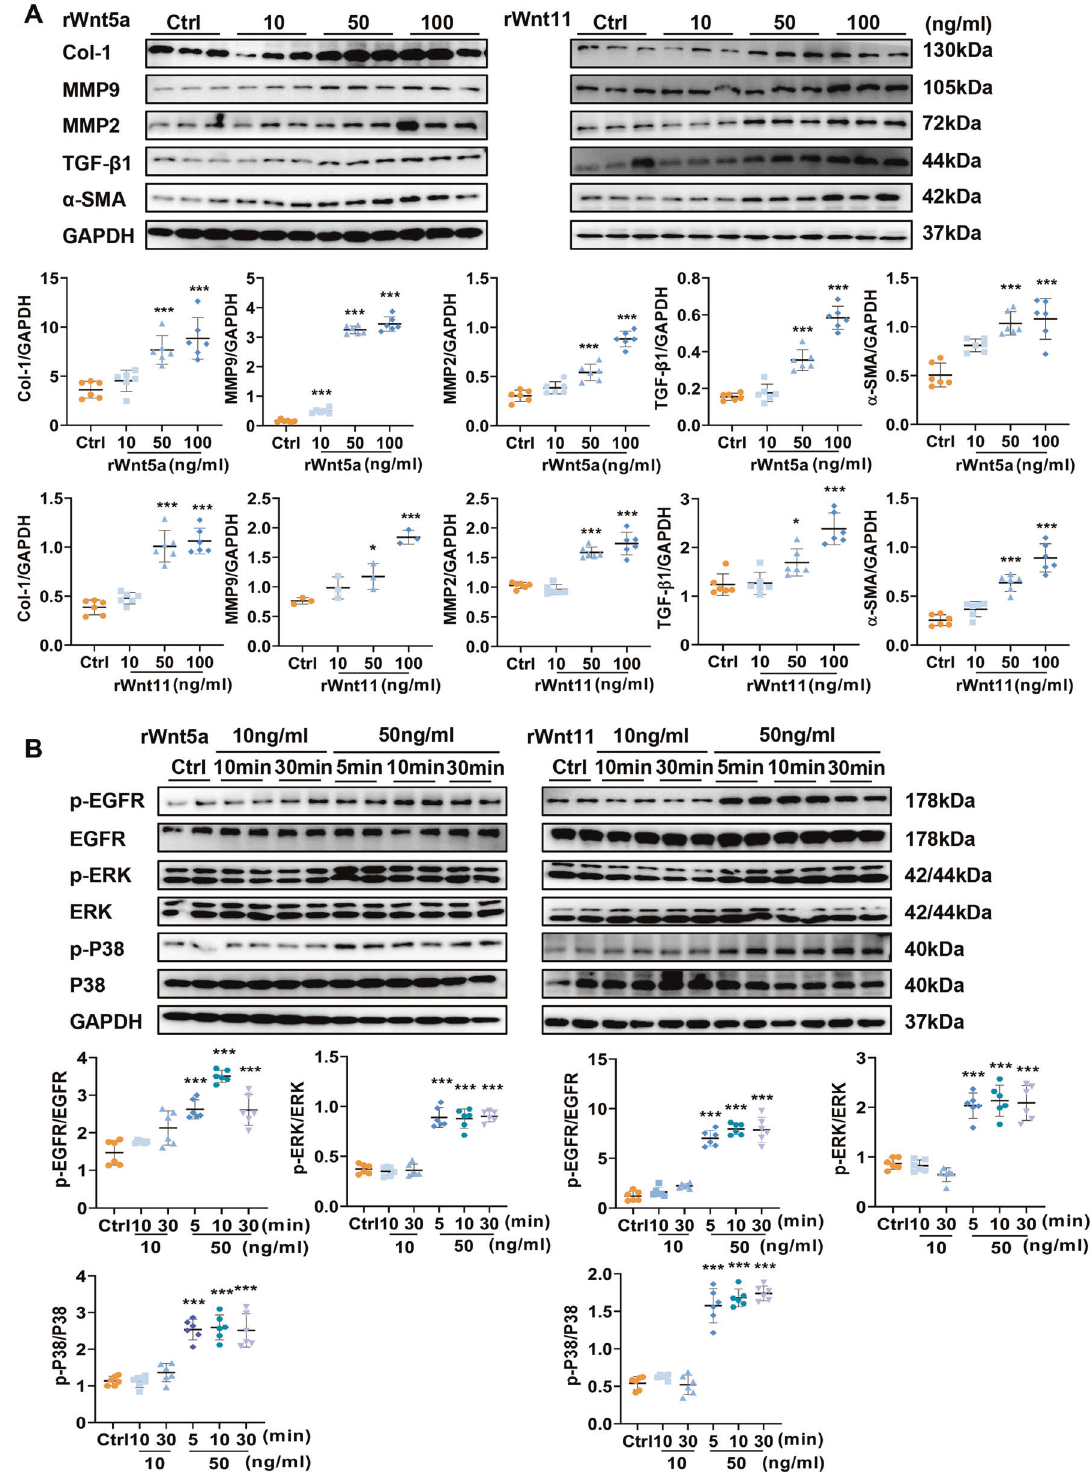
Fig. 6 Exogenous Wnt5a and Wnt11 activates fi brosis-related signaling in neonatal rat cardiac fi broblasts. A The expression of Col-1, MMP9, MMP2, and TGF- β 1 were detected by western blot analysis in cardiac fi broblasts stimulated with exogenous recombinant rat Wnt5a (rWnt5a) or Wnt11 (rWnt11) at different concentrations (0, 10, 50, 100 ng/ml) for 24 h. n = 6/group. B The levels of p-EGFR, p-ERK, and p-P38 were examined in cardiac fi broblasts stimulated with exogenous recombinant rat Wnt5a (rWnt5a) or Wnt11 (rWnt11) at different concentrations (0, 10, 50, 100 ng/ml) and different time-points (0, 5, 10, 30 min), n = 6/group. All data were shown as mean ± SEM; * P < 0.05, ** P < 0.01, *** P < 0.001.